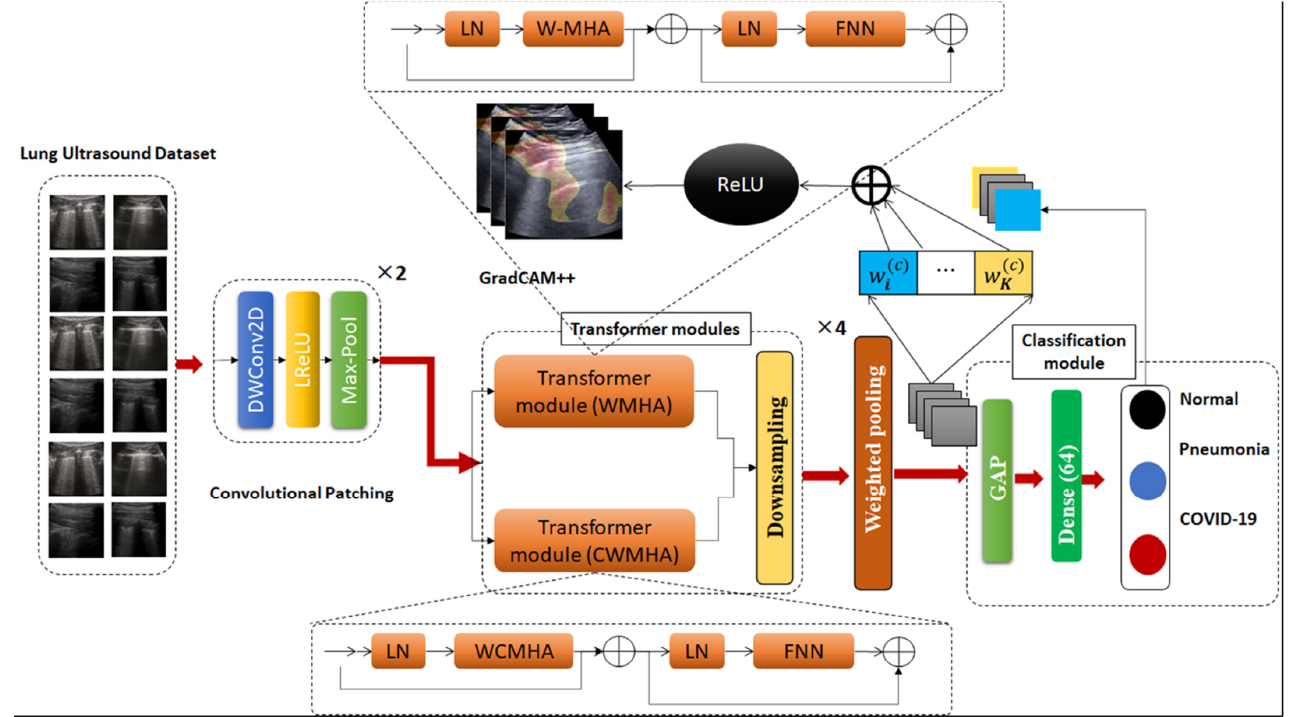
Figure 1. Illustration of the proposed explainable convolutional transformer network for screening pneumonia from lung ultrasound data.